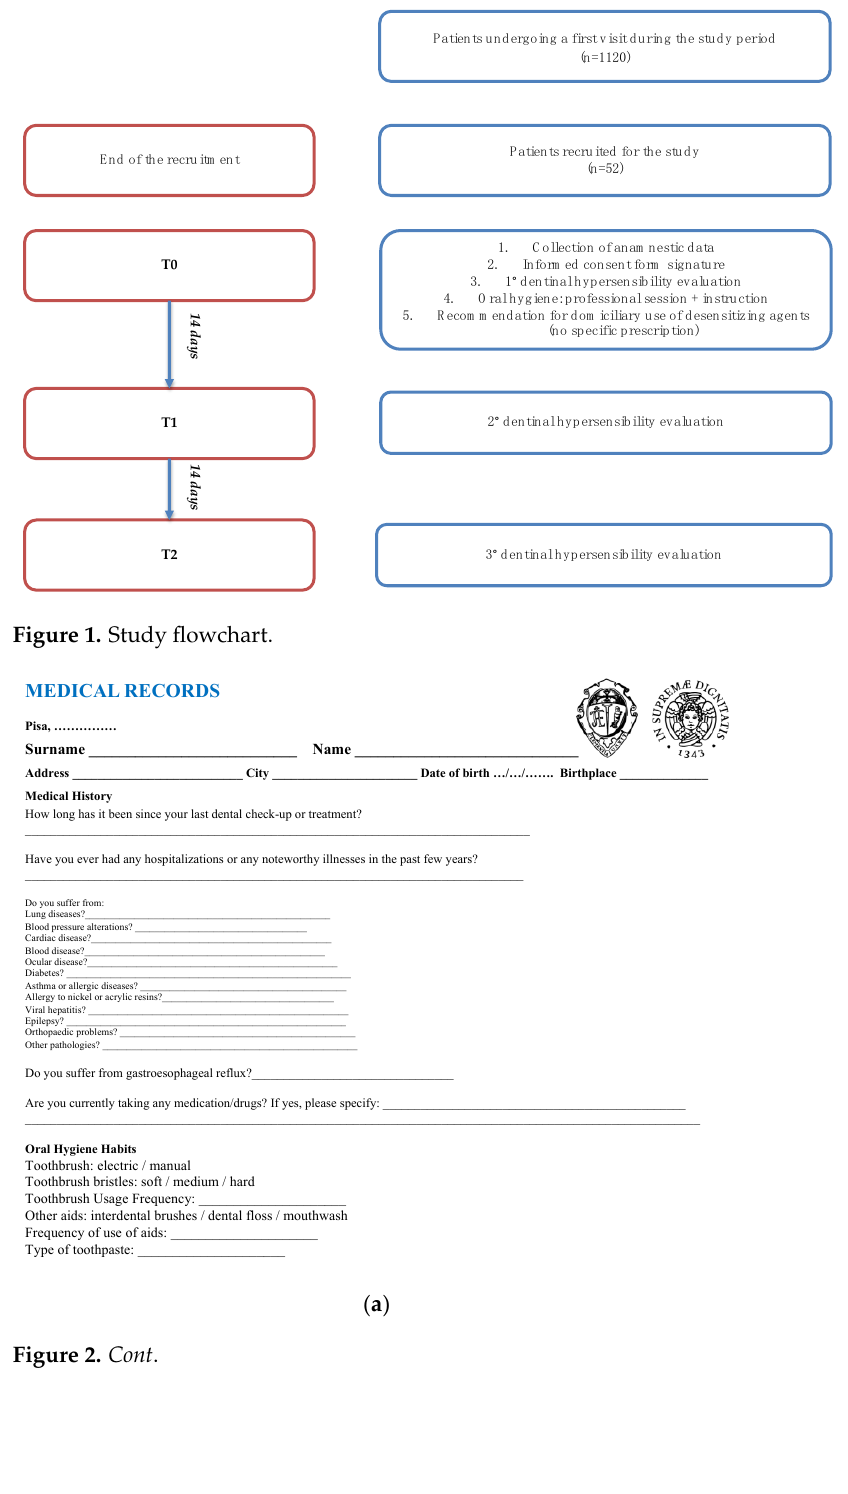
Table 1. Study population descriptive data.